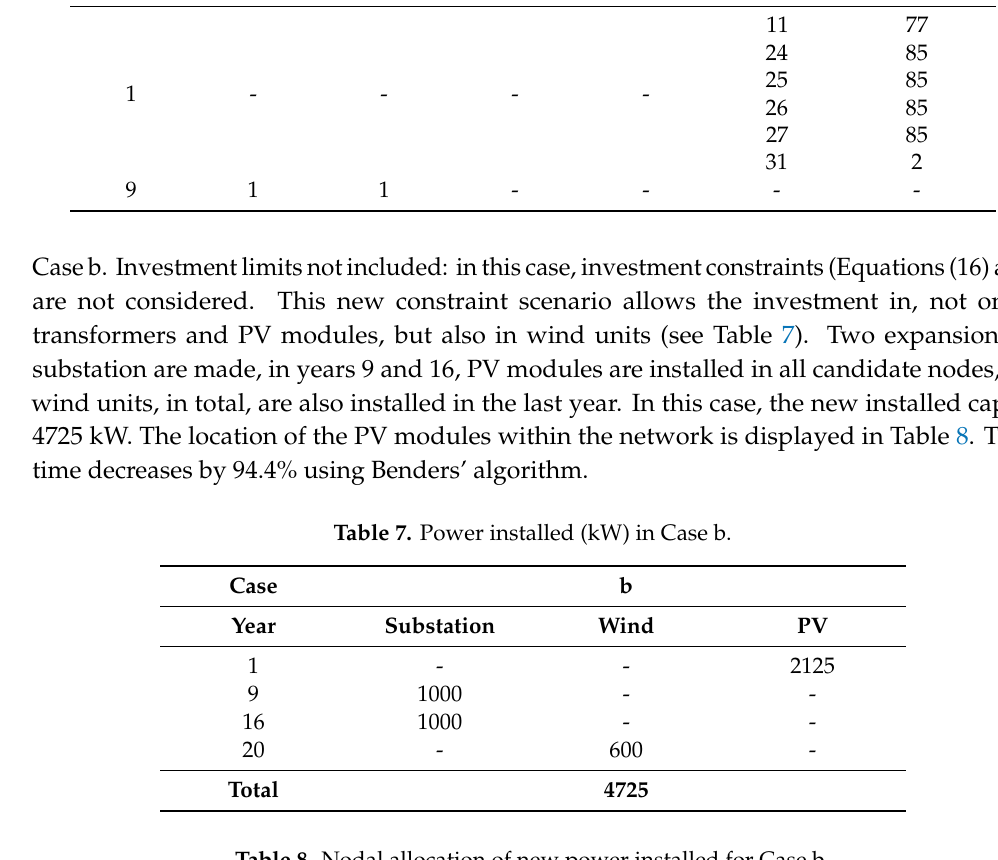
Table 8. Nodal allocation of new power installed for Case